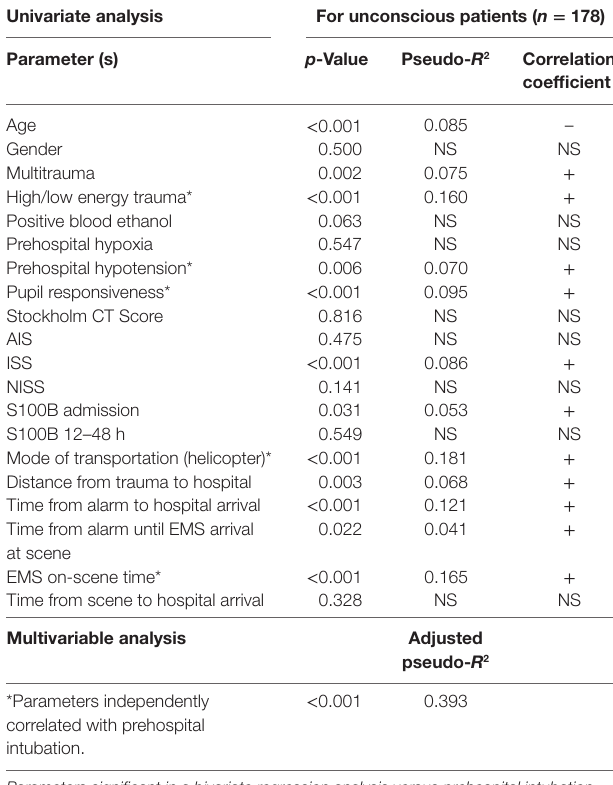
TaBle 3 | Parameters correlated with prehospital intubation in the unconscious population. Univariate